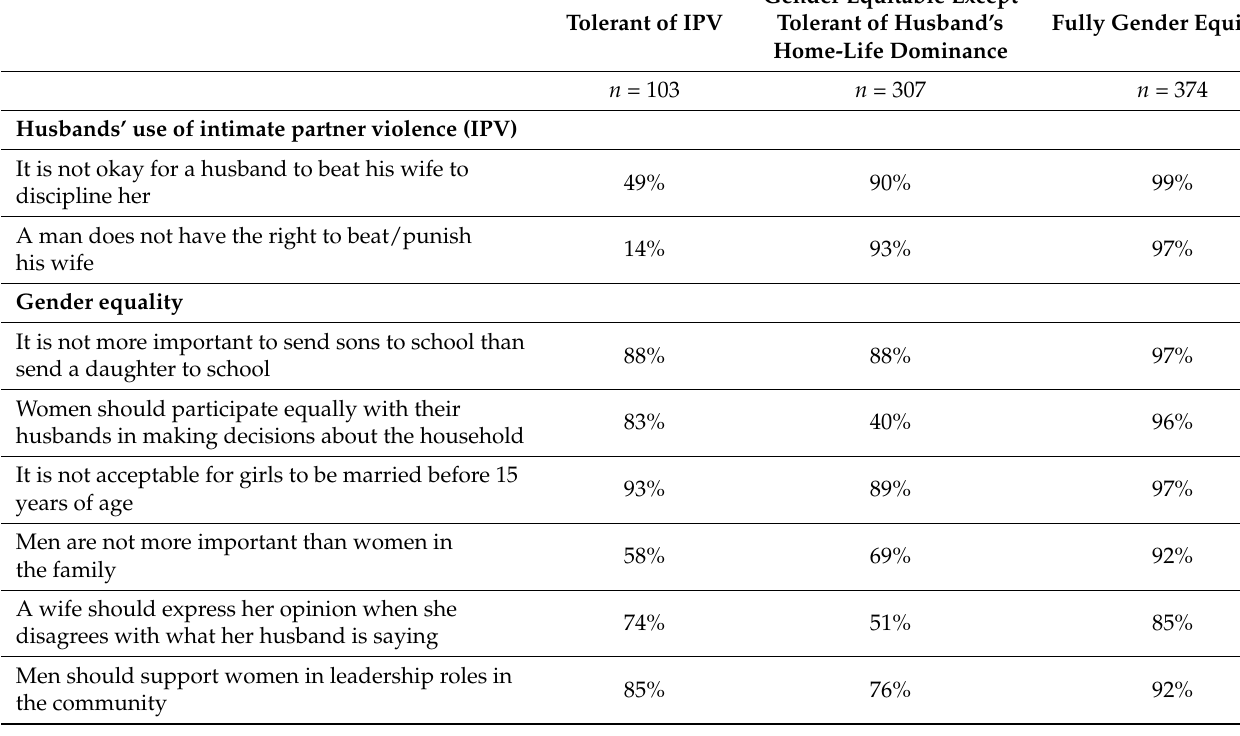
Table 2. Latent classes and percent